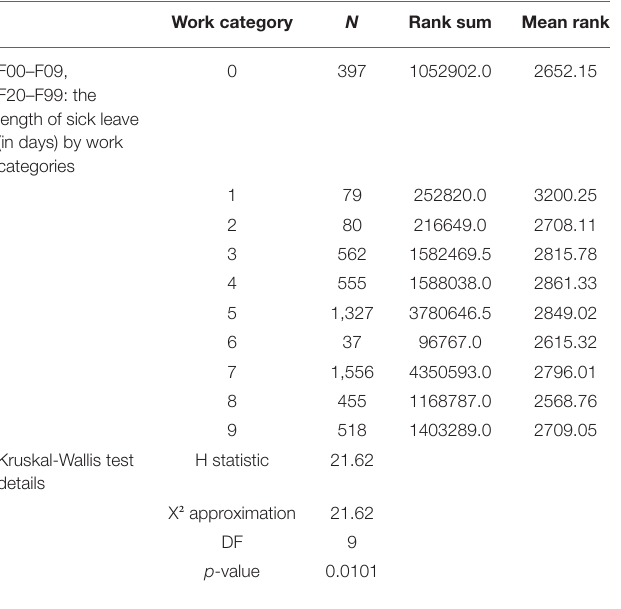
TABLE 5 | Descriptive statistics: the average length of sick leave in the study sample of young adults aged 15–29 years, according to International Statistical Classification of Diseases and Related Health Problems, version 10, the Czech Republic, 2017. ICD −